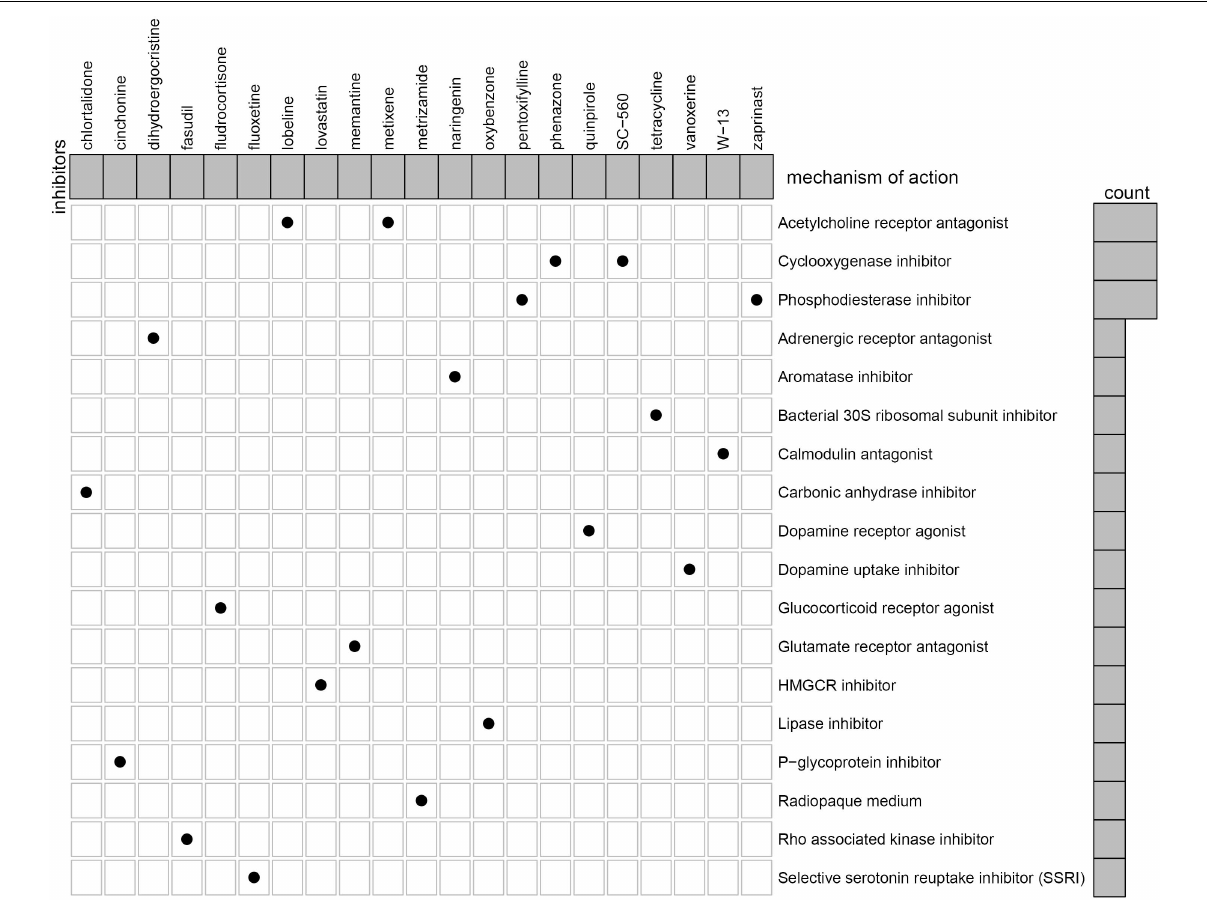
FIGURE 10 | Identification of the small molecular compounds and its mechanism of action for the treatment of